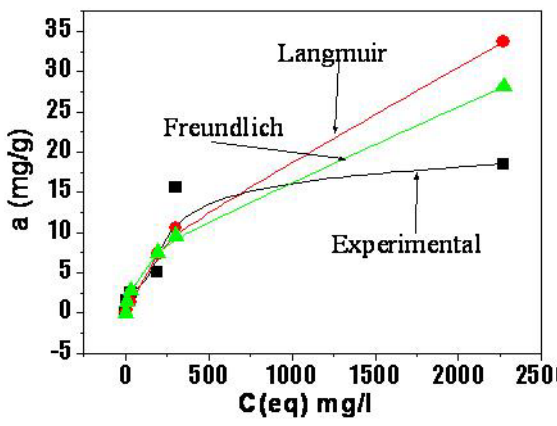
Fig. 1 Chromate adsorption on ODA-clinoptilolite-rich tuff.